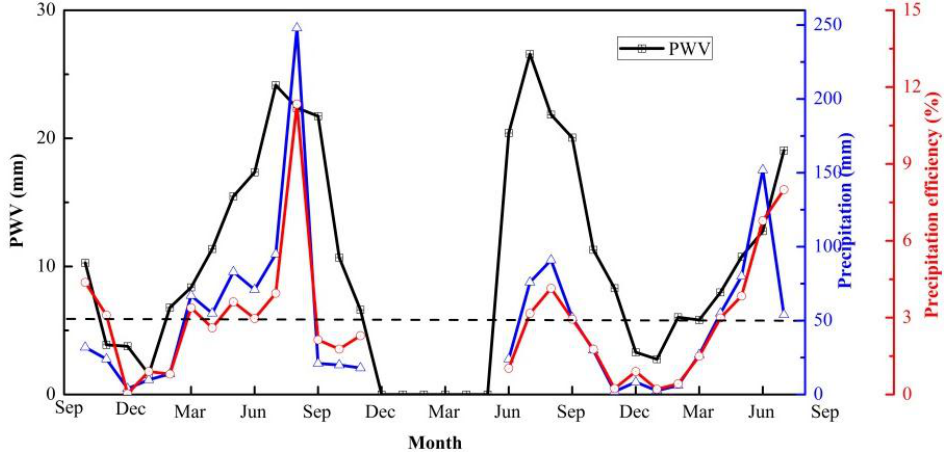
Figure 11. The seasonal variations in averaged PWV, precipitation and precipitation efficiency.